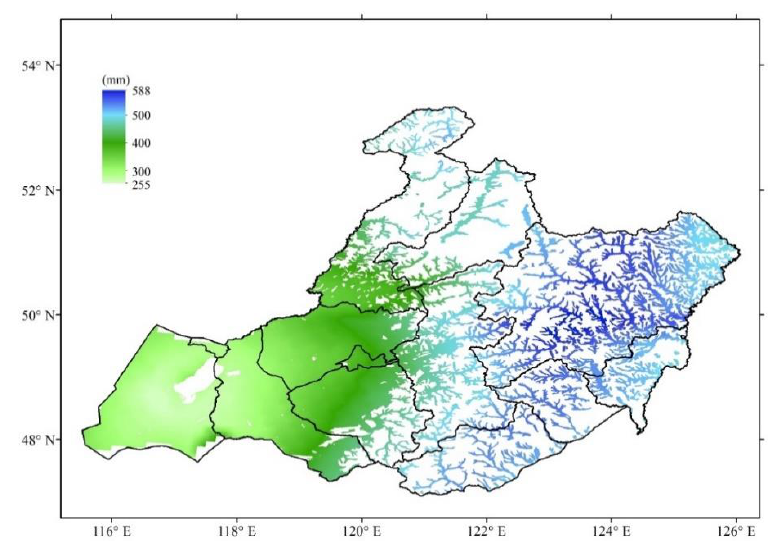
Figure 2. The multiyear annual average precipitation during 1979–2015. The Hulun Buir grassland covers an area of approximately 100,000 km 2 in the middle latitudes of Eurasia, between 115°31′ E and 126°04′ E and 47°05′ N and 53°20′ N. The region is located northeast of the temperate grasslands in China. Due to the high latitude, the heat from the ground radiation is reduced, and the temperatures are relatively low. This grassland lies far from the direct influence of the ocean. In addition, this area is controlled by the Mongolian high-pressure air mass. Therefore, the Hulun Buir grassland has a temperate continental monsoon climate. The Greater Khingan Mountains run northeast to southwest and through the center of Hulun Buir City, thus reducing the chances of monsoons from the Southeast Pacific reaching deep into the mainland. Simultaneously, because of the natural barrier created by the Greater Khingan Mountains, the cold current from Siberian Mongolia is blocked. Thus, there is a clear difference in climates on the two sides of these mountains. To the east of the Greater Khingan Mountains, there is a semi-humid forest grassland climate with four distinct seasons, a mild climate, and heavy rainfall. In comparison, the west side of the Greater Khingan Mountains has a semi-humid and semi-arid grassland climate and is colder and drier with less rainfall. The Greater Khingan Mountains form a cold and humid forest climate [47]. Hulun Buir is the most concentrated and representative area of a temperate meadow steppe in China, in which many types of meadow steppe ecosystems develop. From the east humid region to the west semi-arid region, an ecological geographical gradient of climatic dryness is formed from east to west (Figure 3). Thus, zonal vegetation is divided from east to west, with a temperate meadow steppe and temperate steppe predominant in the west, lowland meadow, and upland meadow in the east